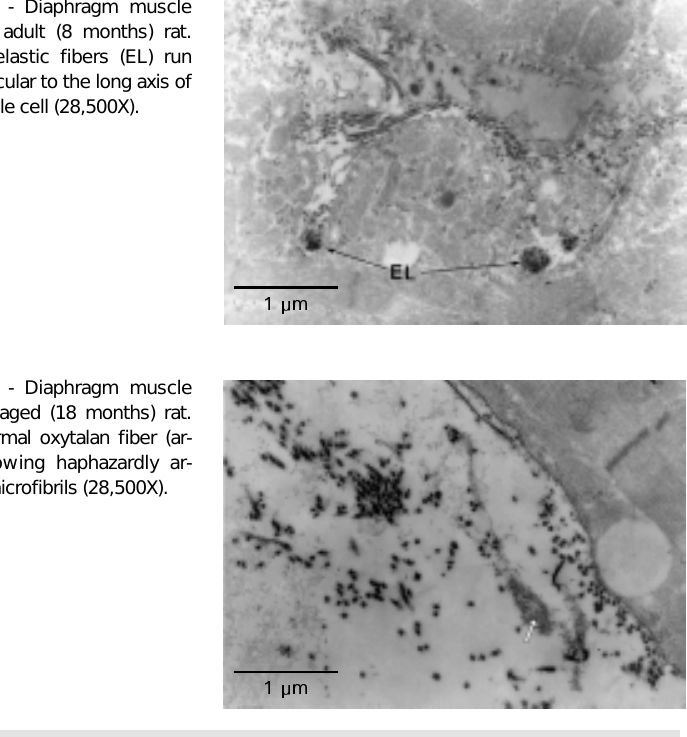
perpendicular to the long axis of the muscle cell (28,500X).